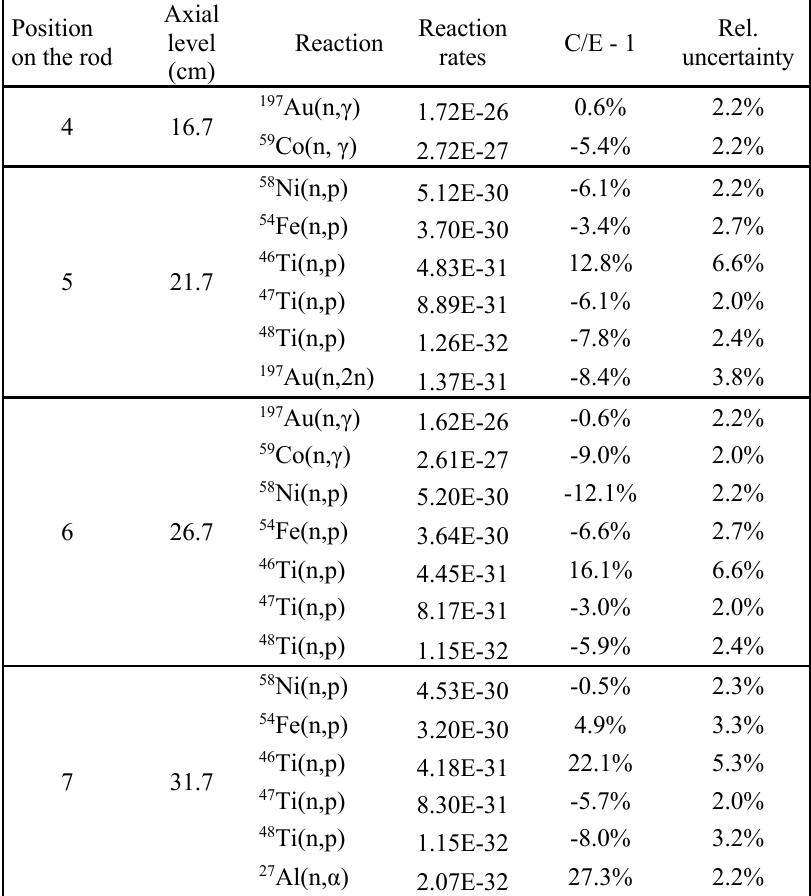
Table V. Measured reaction rates in the Teflon module normalized to one target nucleus and neutron in the core